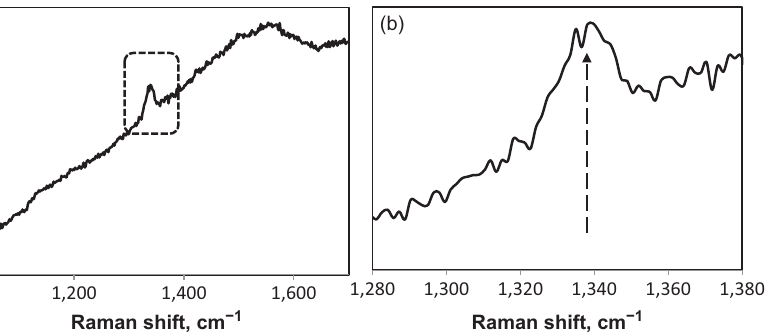
Figure 4: Raman spectra of continuous diamond coatings formed on Kovar alloy substrate precoated with an Al interlayer; (b) is a magnified view of the major peak in